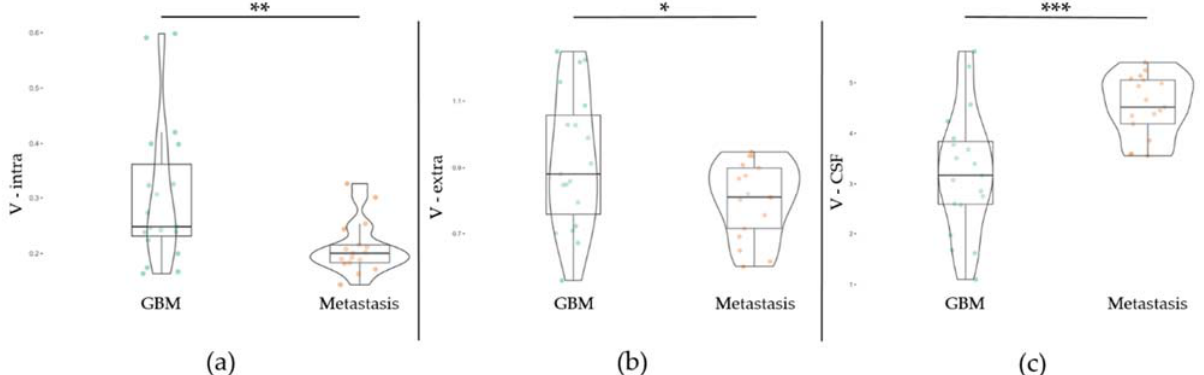
Figure 3. Axial FLAIR ( a , c ) and parametric V ‐ CSF ‐ maps ( b , d ) in a left centroparietal GBM ( a , b ) and left frontal metastasis ( c , d ). Of note, the metastasis shows a relative increase in perilesional V ‐ CSF compared with GBM ( d , b ).